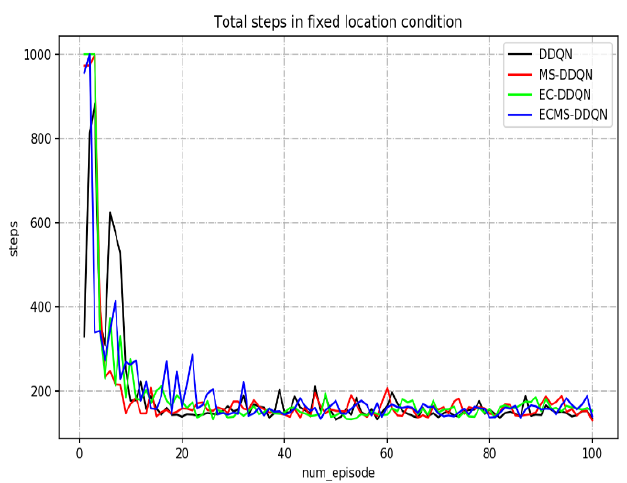
Figure 8. The number of steps consumed by the four algorithms in a random location scene.